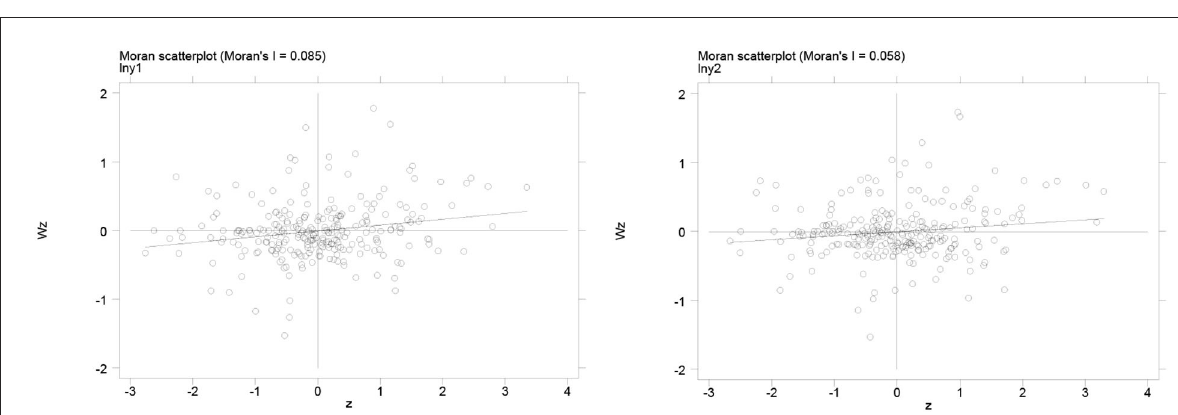
through average years of education per capita (37). The